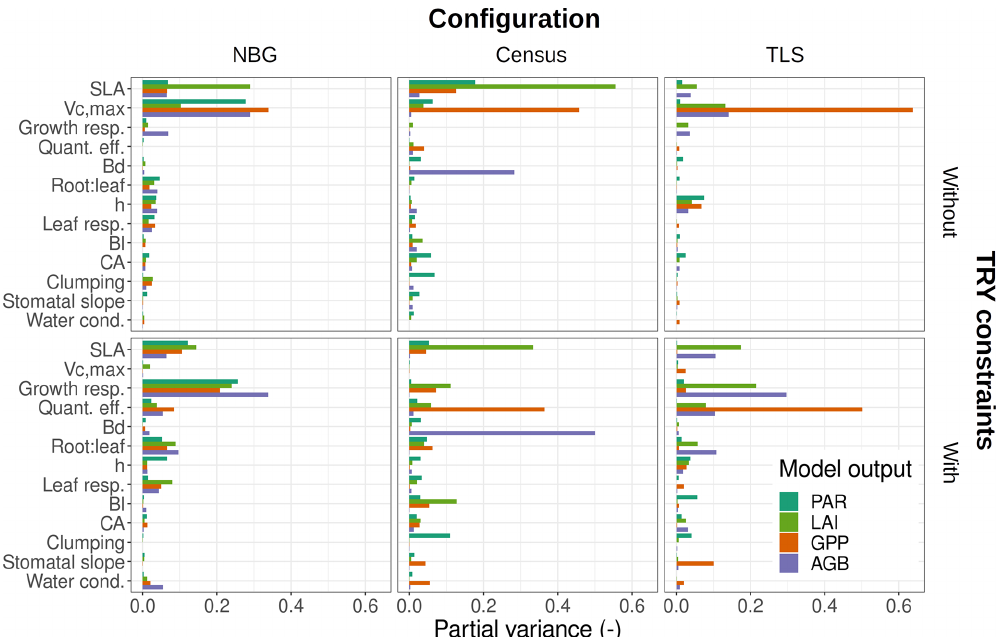
Figure 5. Contributions of individual or allometric parameters (Bd, Bl, CA, and height include all parameters for the respective allometries; see Table 2) to the predicted uncertainties in ED2.2 of multiple state variables (PAR: photosynthetically active radiation reaching the ground, LAI: leaf-on ecosystem leaf area index, AGB: final ecosystem aboveground biomass, GPP: leaf-on ecosystem gross primary production) for multiple model configurations (columns) with or without TRY constraints on SLA and V c , max (rows). Only those parameters that contributed at least once to 5% or more of the total variance were included in the panels. Parameter descriptions and distributions are given in Table 4. The settings of the model configurations are detailed in Table 5.